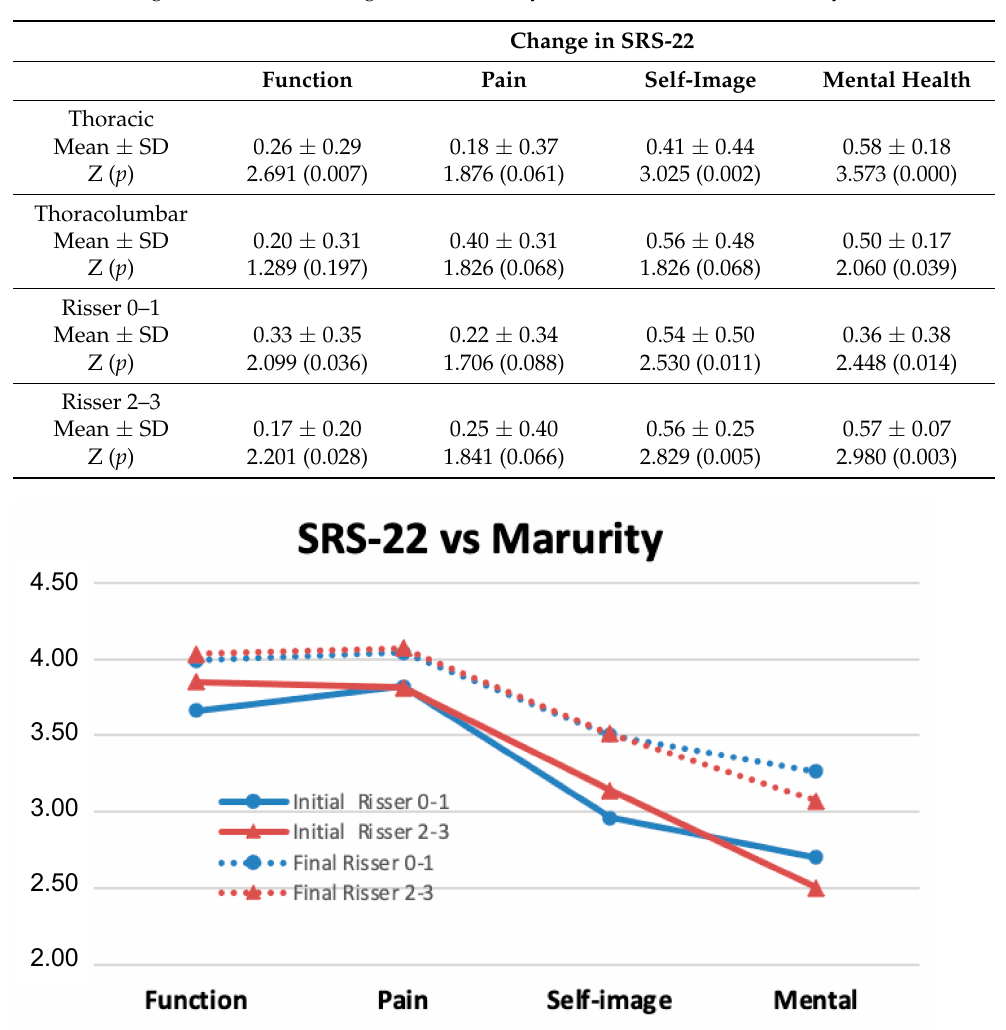
Figure 10. Results of the SRS-22 questionnaire according to the degree of skeletal maturity. A significant improvement was observed in almost all the studied domains.